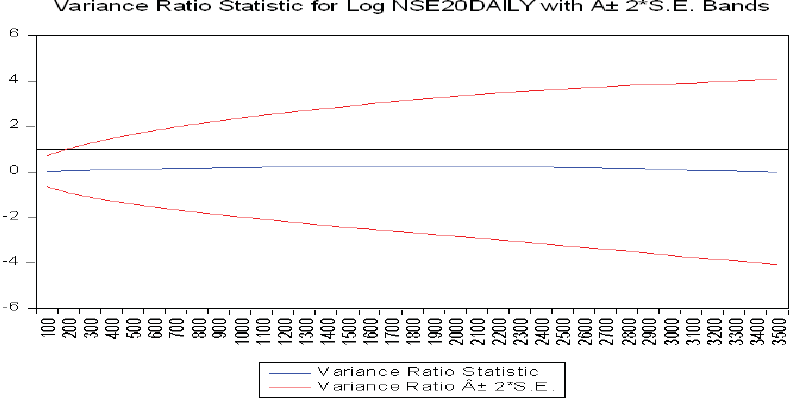
Fig. 1. Graphical illustration of the efficiency of the NSE 20 share index (daily data over the test